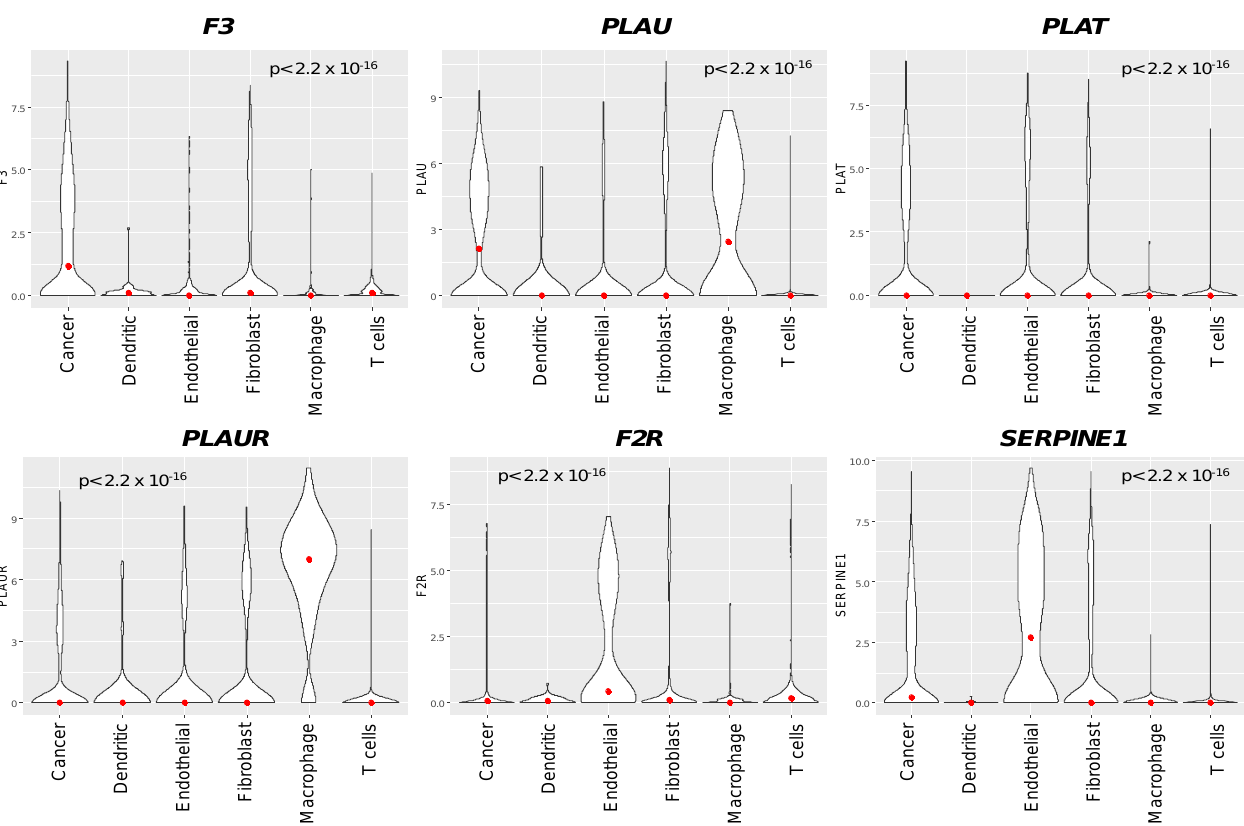
Figure 4. Single-cell analysis of the coagulome in different cell subpopulations in OSCC. Violin plots showing the mRNA expression of the core coagulome genes ( F3 , PLAU , PLAT , PLAUR , F2R and SERPINE1 ) in different cell populations present in OSCC (malignant cancer cells, T cells, dendritic cells, macrophages, endothelial cells and fibroblasts). Data are shown from OSCC tumors analyzed by scRNA-seq in Puram et al. [28] (GSE103322). The red dots represent the median values. The indicated p values were obtained with the Kruskal–Wallis